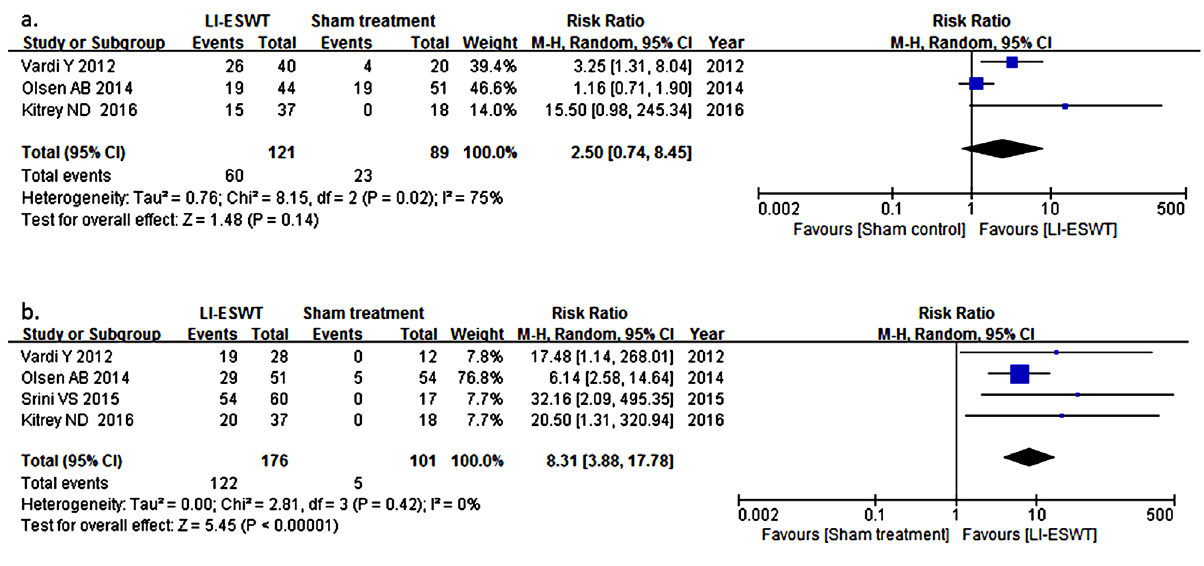
Figure 2 - Forest plots of random effects model of risk ratio of effective treatment of LI-ESWT for ED in terms of International Index of Erectile Function-Erectile Function Domain (a) and Erectile Hardness Score